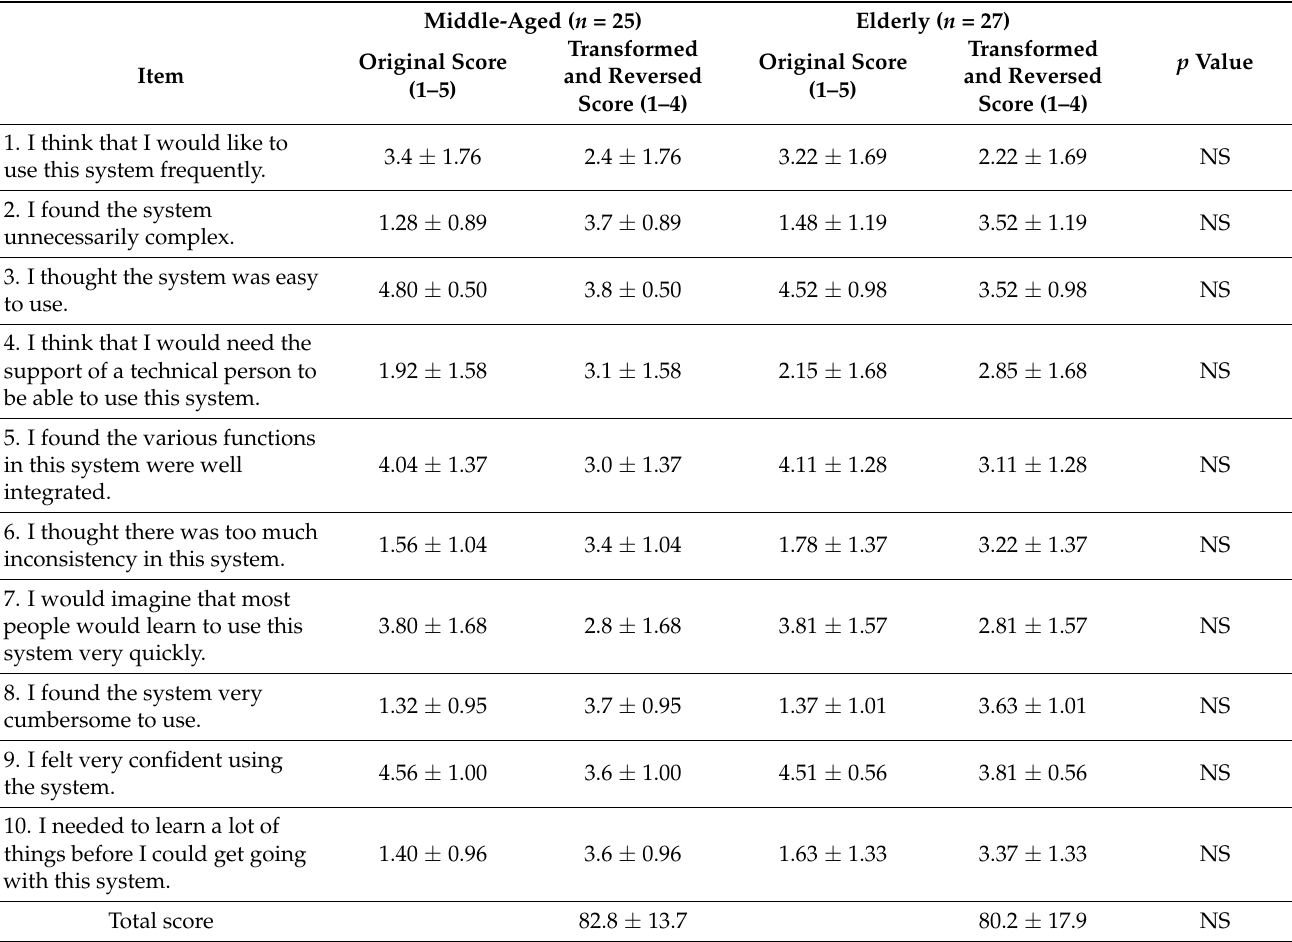
Table 3. Means ± SDs for the System Usability Scale by item and group showing original and transformed